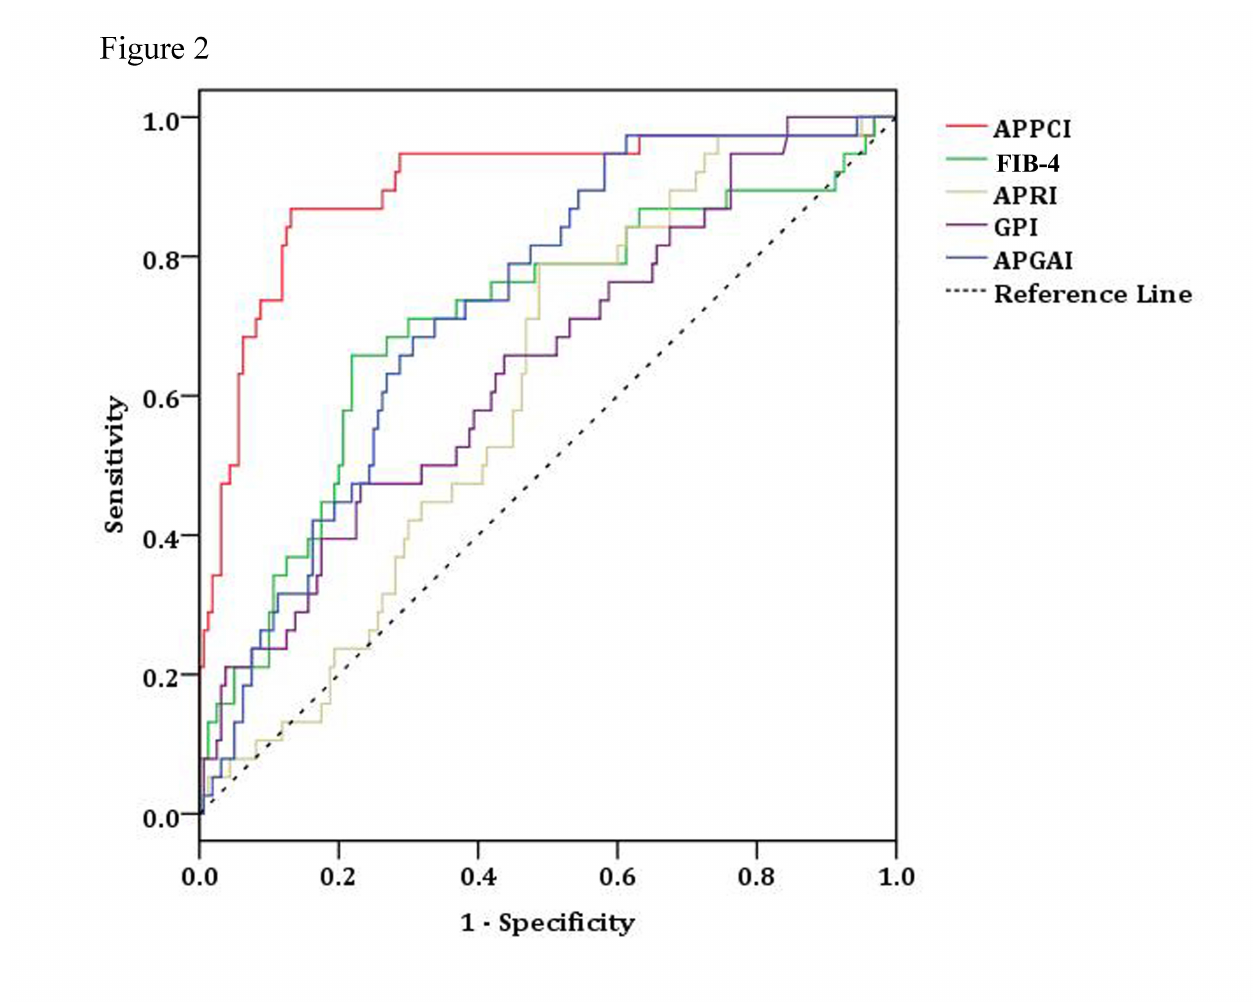
Figure 2. ROC curves of the APPCI, FI, APRI, GPI, and APGA noninvasive models in all study subjects.